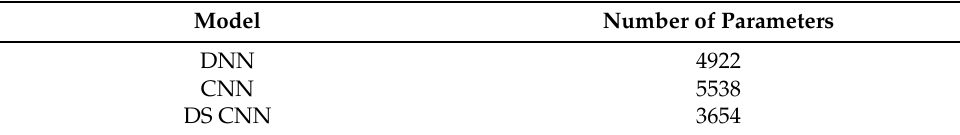
Table 7. The number of parameters of each